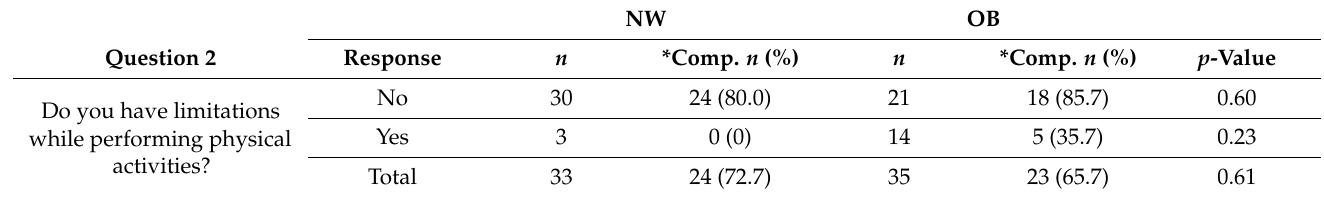
Table 3. Exercise limitation assessment, showing the compatibility of Question 2 with the NYHA.